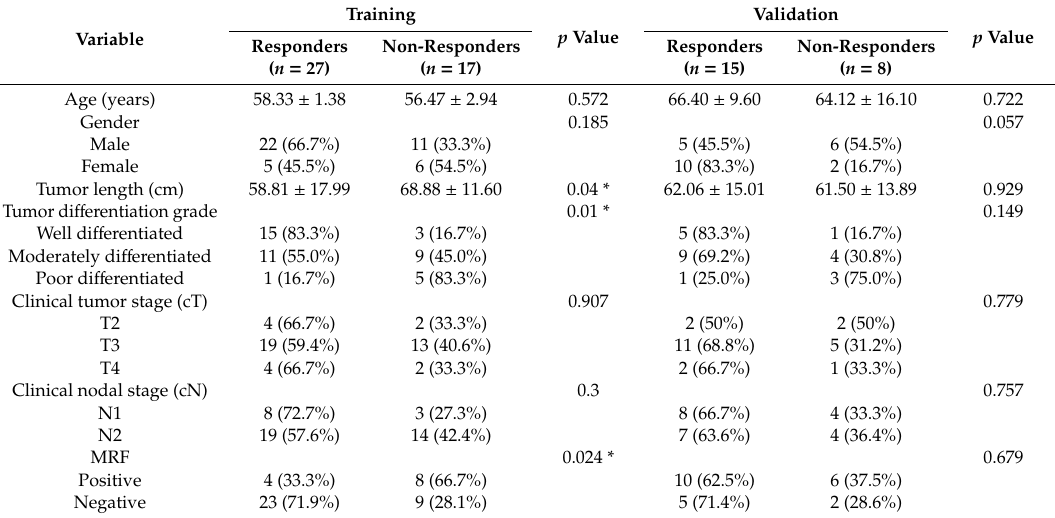
Table 1. Baseline characteristics of the study